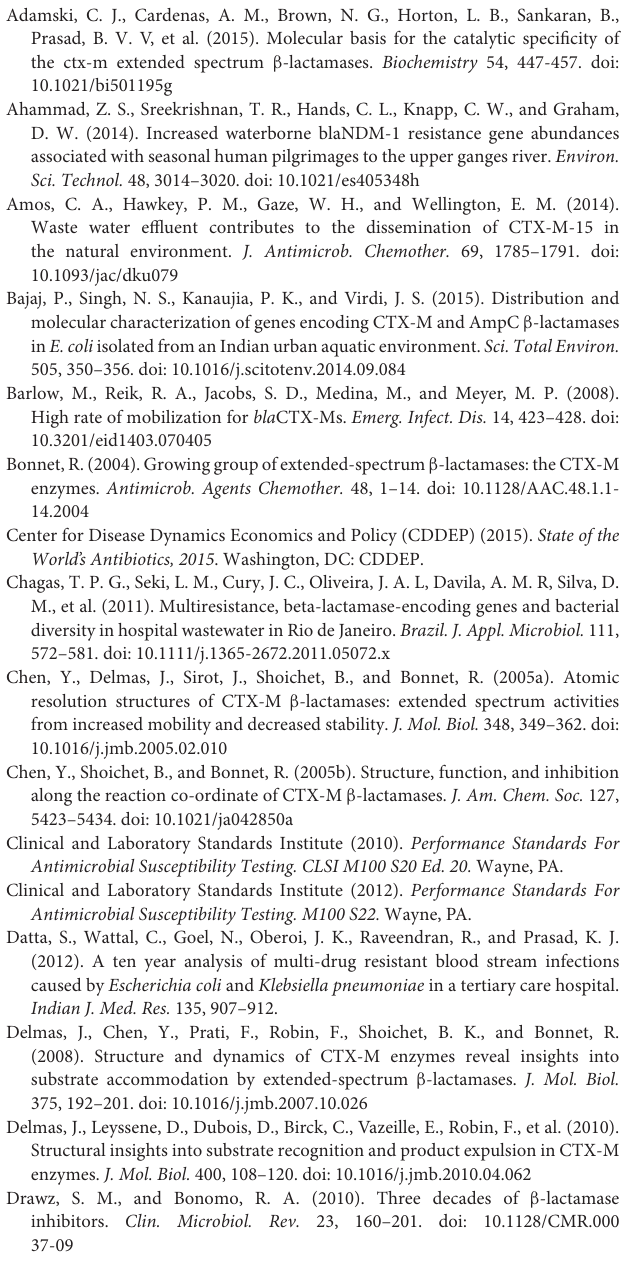
Table S3 | (A) Susceptibilities of ESBL + isolates to β -lactam class of antibiotics. (B) Susceptibilities of ESBL + isolates to non- β -lactam classes of antibiotics. Figure S1 | Multiple sequence alignment of CTX-M β -lactamases. Amino acid sequences of representative members from five different groups of CTX-M ESBLs are aligned using CLUSTAL W program. Asterisks indicate identical amino acids. The four conserved domains of class A β -lactamases are marked with red